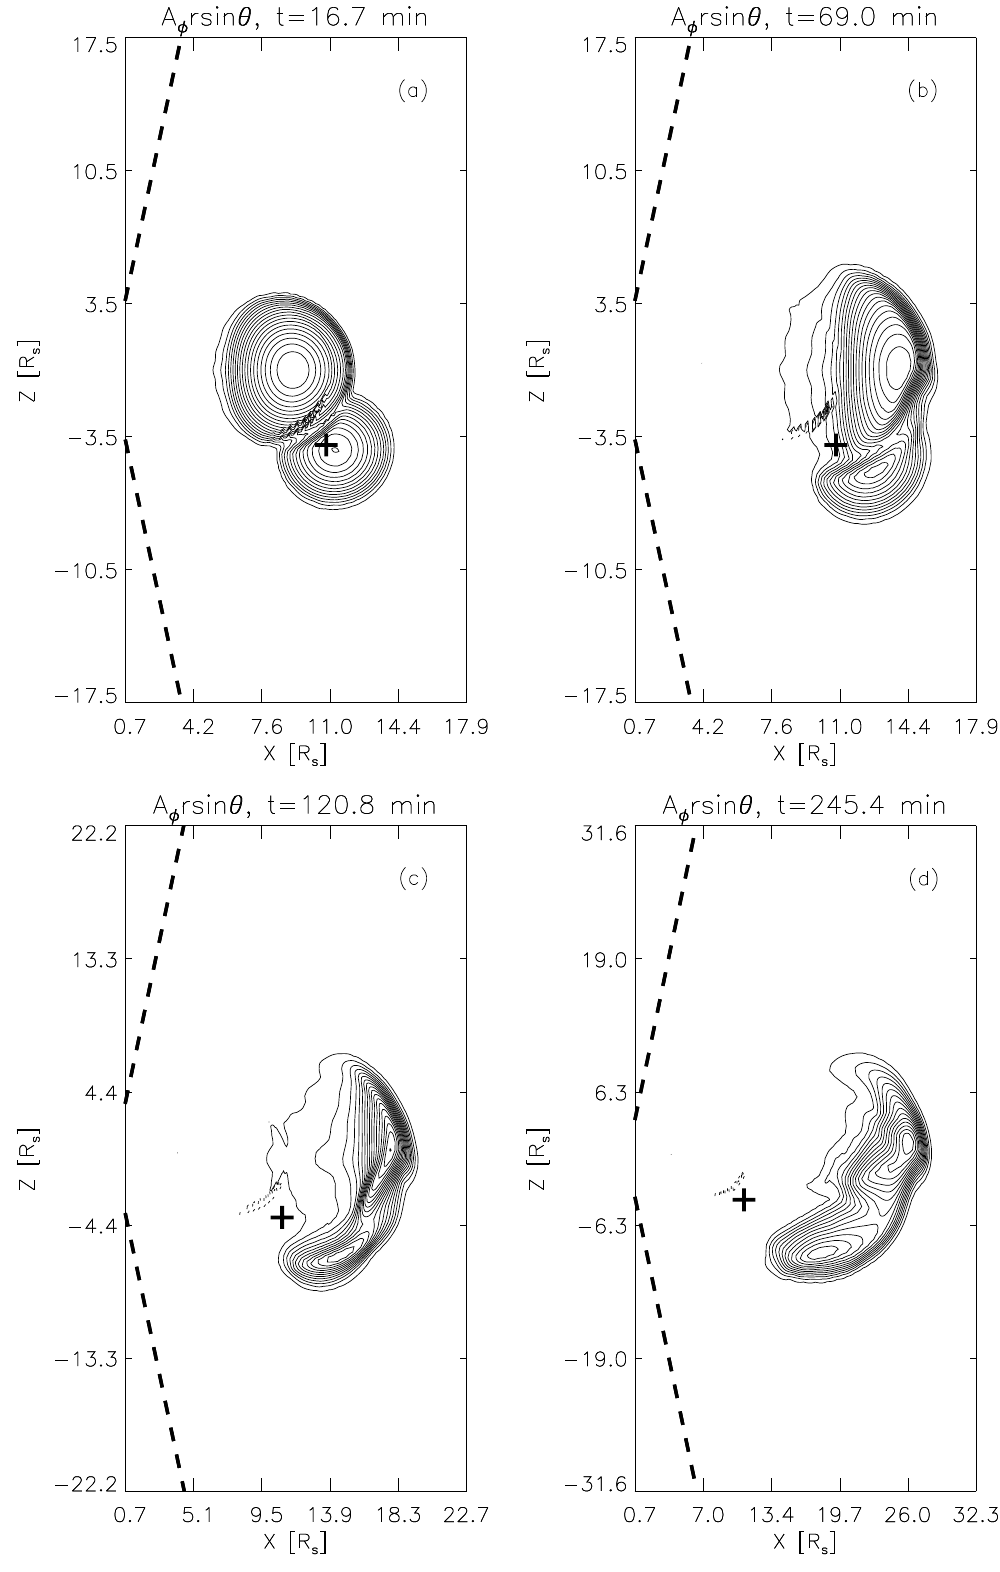
Fig. 4. The magnetic field lines for a case of CME interaction where the two CMEs are initially separated by 20 ◦ in the meridional direction. The two CMEs have the same sense of rotation of their magnetic